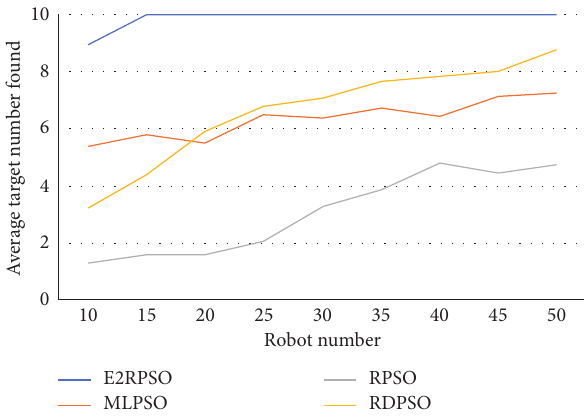
Figure 4: Comparison of average targets found under different population sizes. Table 3: Iteration times and full success rates (%) under different population.